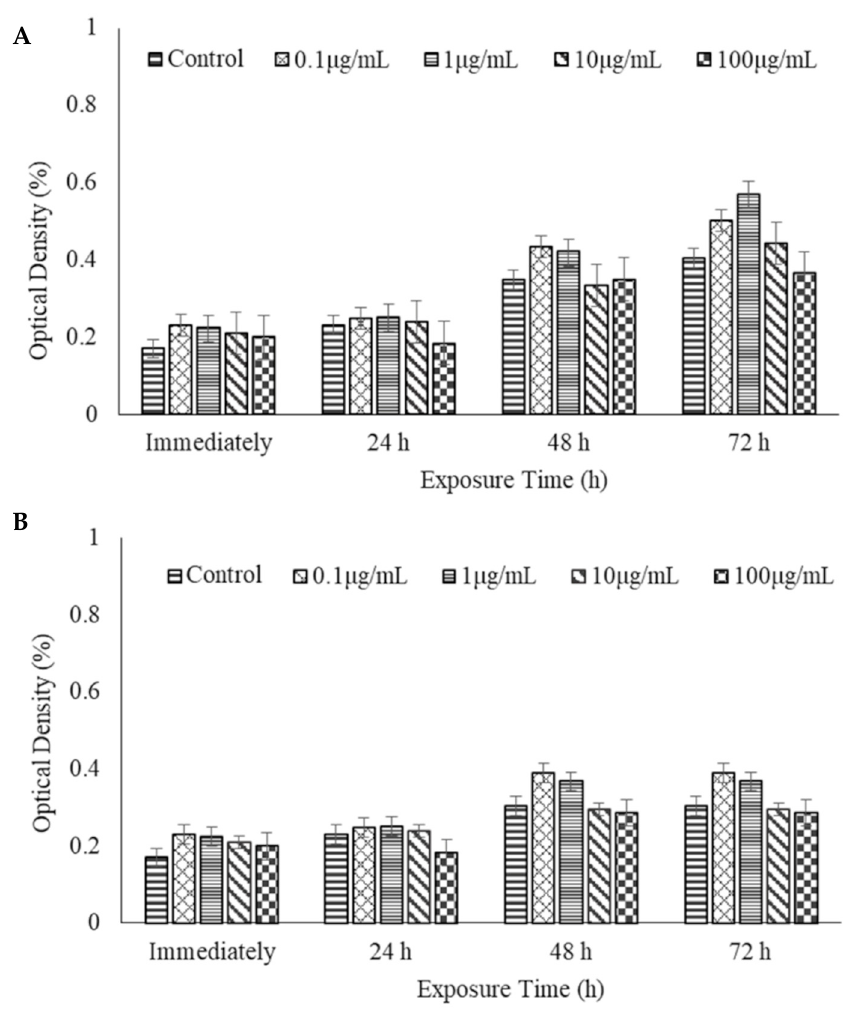
Figure 4. Results of cell viability as a function of the treatments performed with different concentrations of ( A ) empty SPECs and ( B ) oil loaded SPECs. Each value represents the mean of triplicate measurements and varied from the mean by not more than 10%.